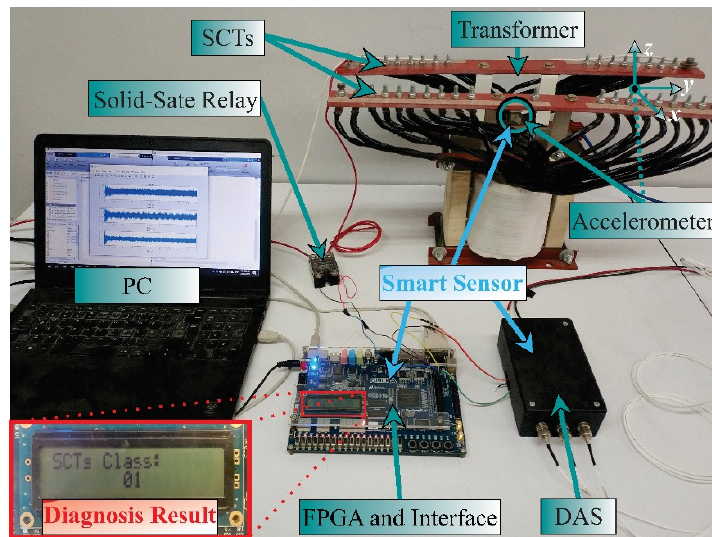
Figure 6. Experimental setup.